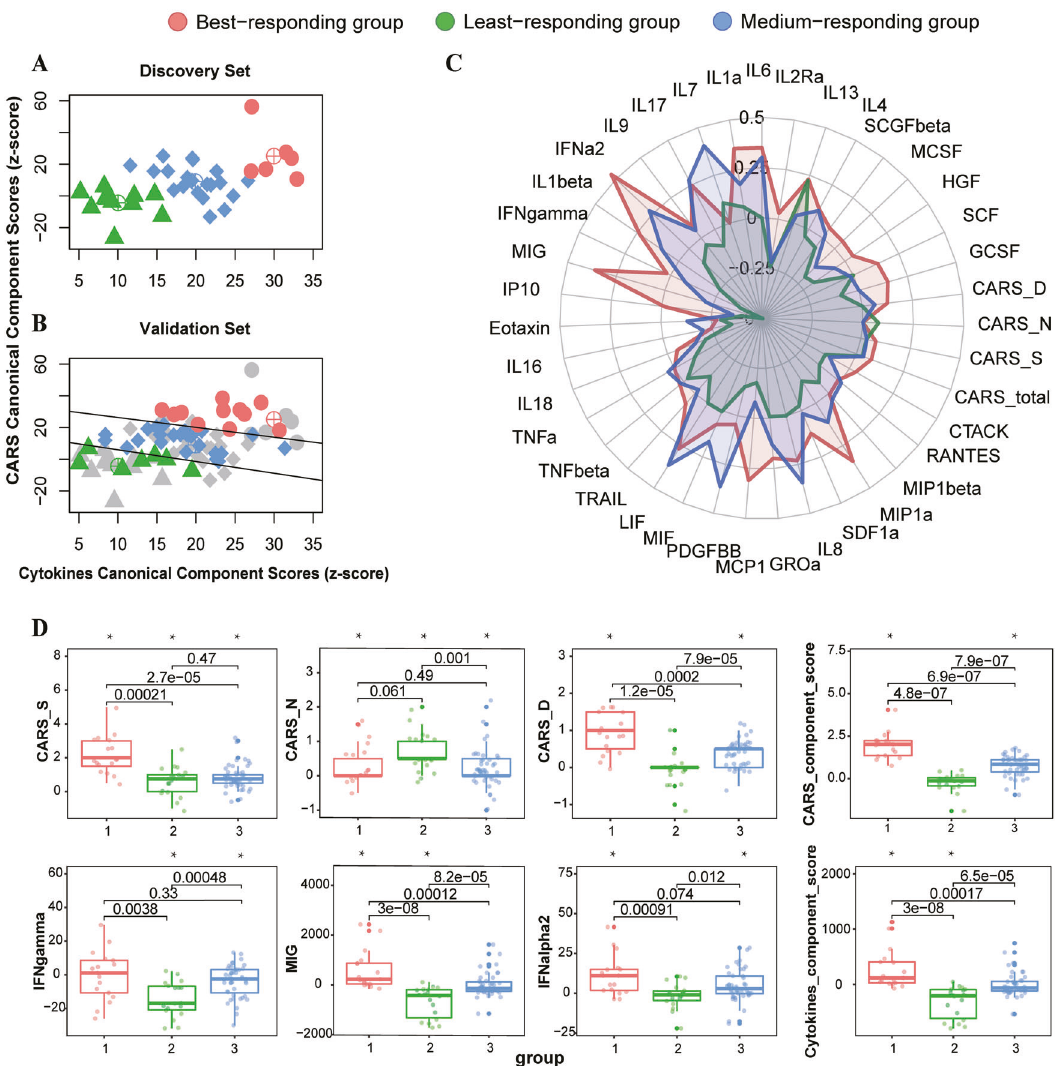
Fig. 2 Differences in three immuno-behavioural groups. K -means cluster plot on the immuno-behavioural plane. K -means cluster analysis was carried out in Discovery Set ( A ) and the patients from the Validation Set were mapped to this immuno-behavioural plane ( B ). C Radar chart for the ratios of changes to baseline of CARS and cytokine levels in 3 immuno-behavioural groups. D Boxplot for the signi fi cant changes of CARS and cytokine levels in 3 immuno-behavioural